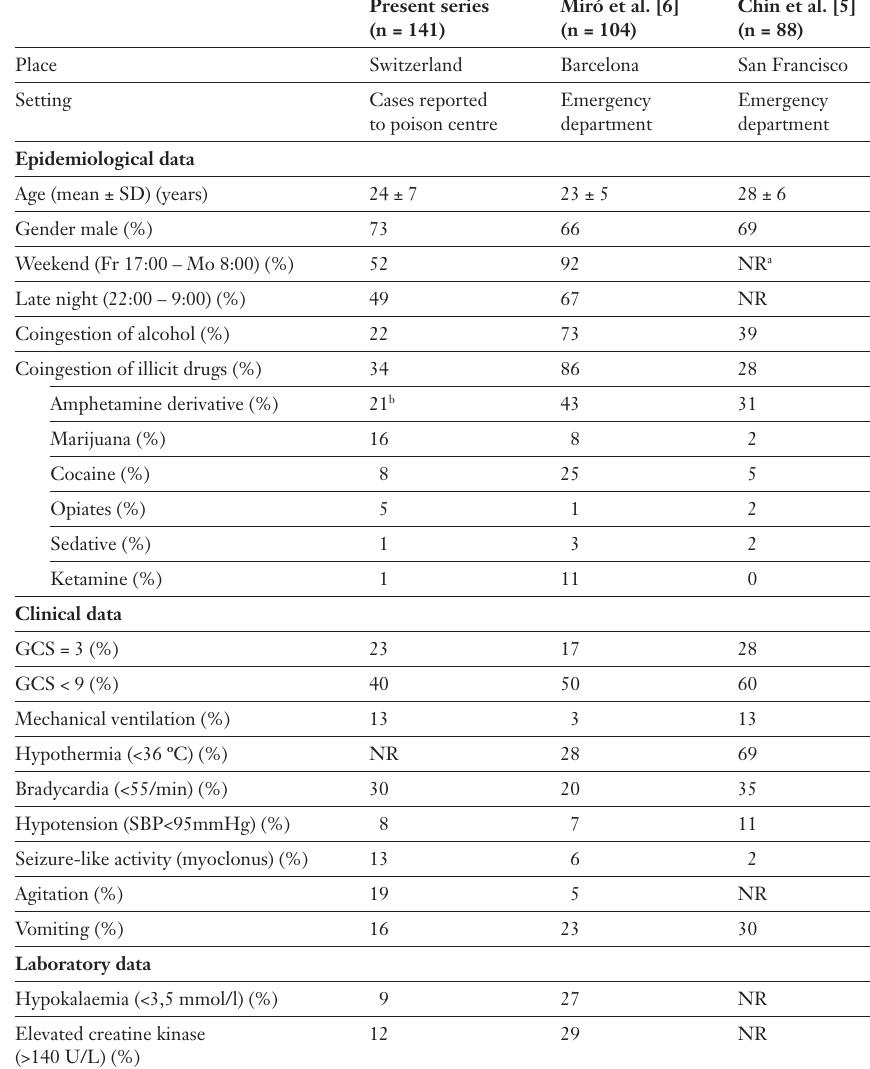
Table 1 Epidemiological and clinical data of pa- tients with GHB or GBL